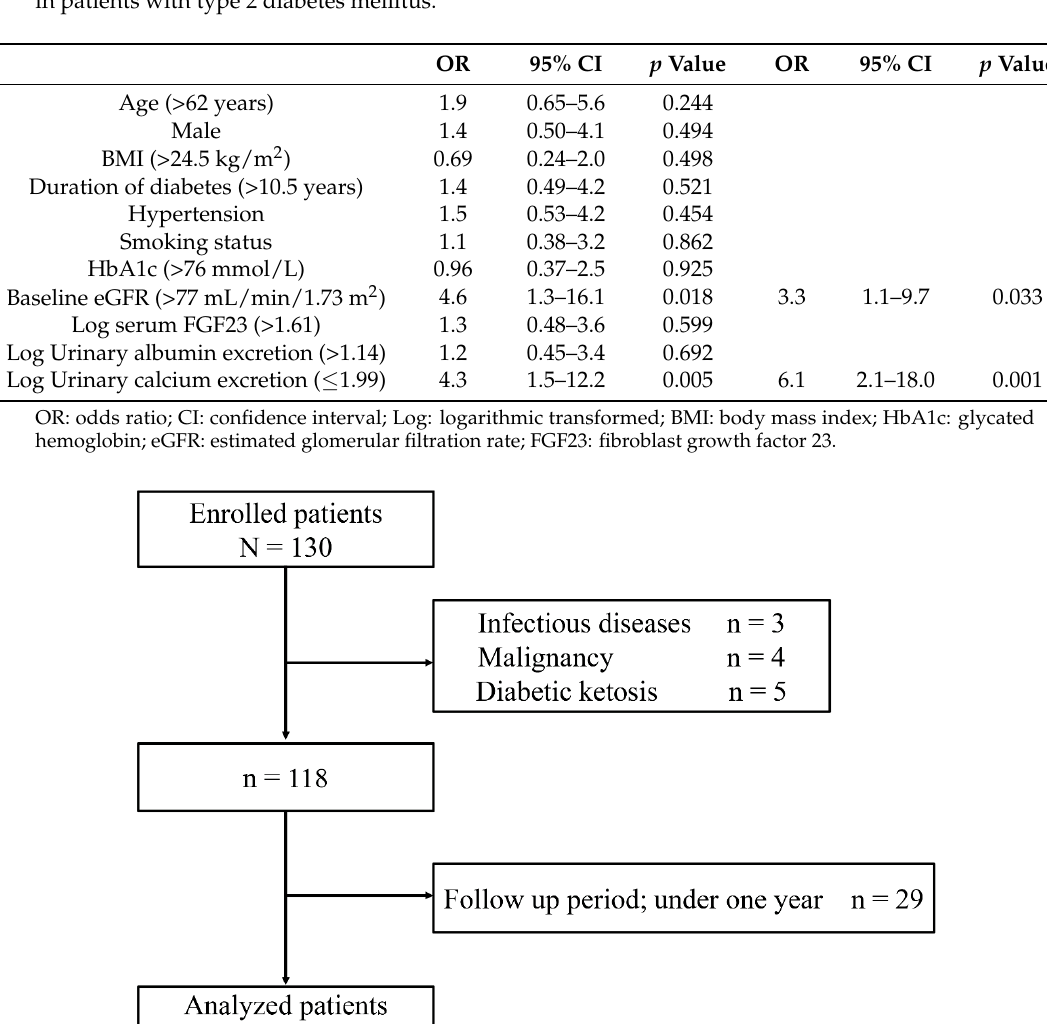
Figure 2. Correlation between Correlation of urinary calcium excretion (U-Ca) and baseline mineral and renal parameters (overall, n = 89). Correlation of urinary calcium excretion (U-Ca) with serum calcium (Ca) ( r = 0.18, p = 0.08) ( A ), serum phosphate (P) ( r = − 0.11, p = 0.30) ( B ), serum intact fibroblast growth factor 23 (FGF23) ( r = − 0.13, p = 0.23) ( C ), and estimated glomerular filtration rate (eGFR) ( r = 0.39, p < 0.001) ( D ) in patients with type 2 diabetes.